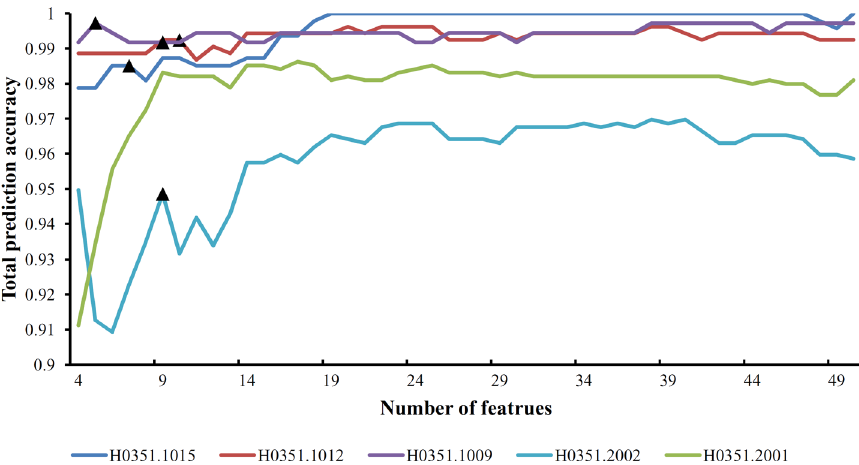
Fig 5. Parts of five IFS-curves using the data of H0351.1016 as the training dataset and the data from other people as the test dataset. The triangle in each curve represents the inflection